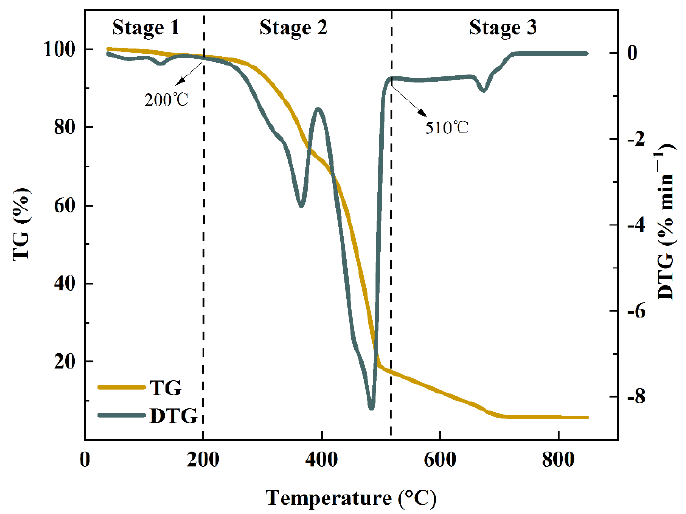
Figure 2. TG-DTG curve of pyrolysis of MS-PP mixtures at a heating rate of 10 °C·min -1.